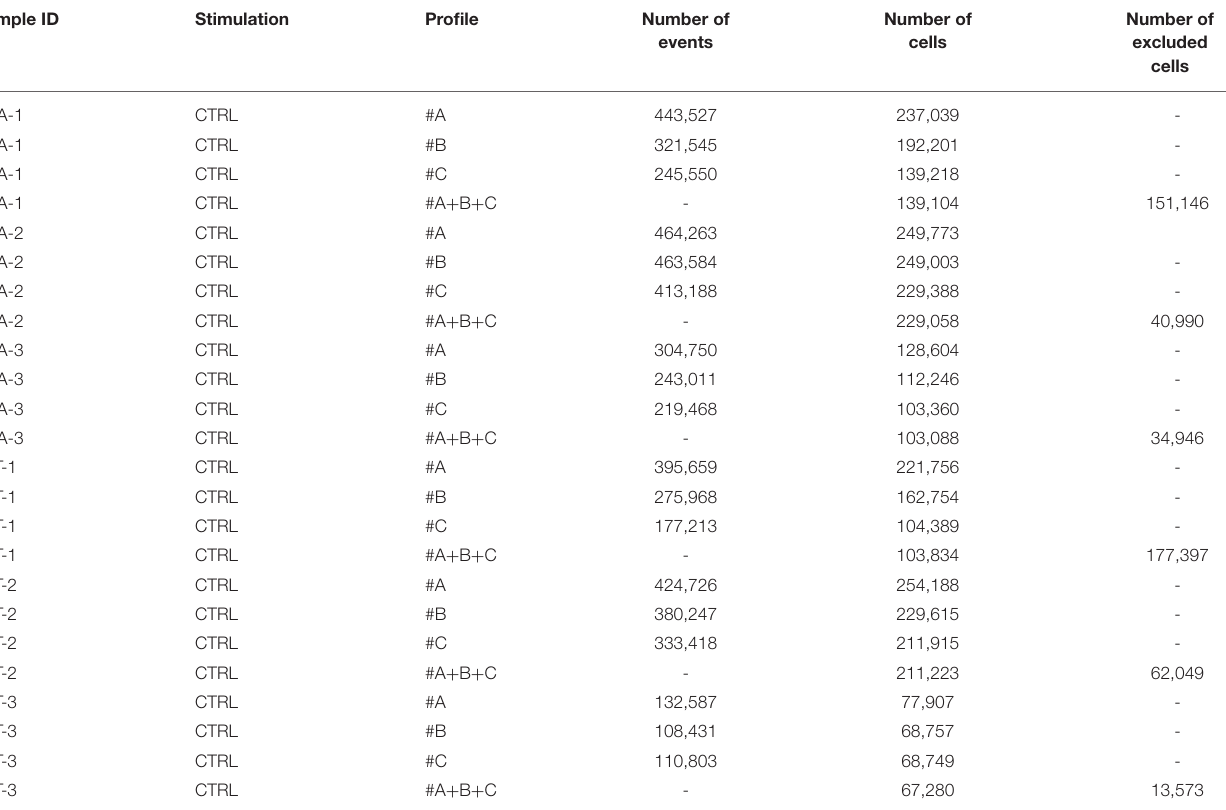
TABLE 3 | Number of events and cells obtained, before and after cell merging, for samples used to characterize specific cell populations from healthy subjects and HIV-infected patients. Sample